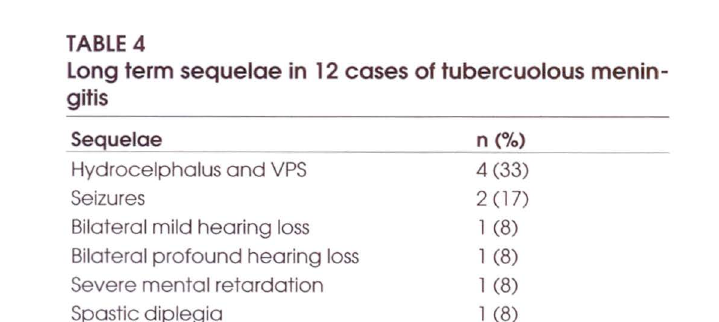
Long term sequelae in 12 cases of tubercuolous